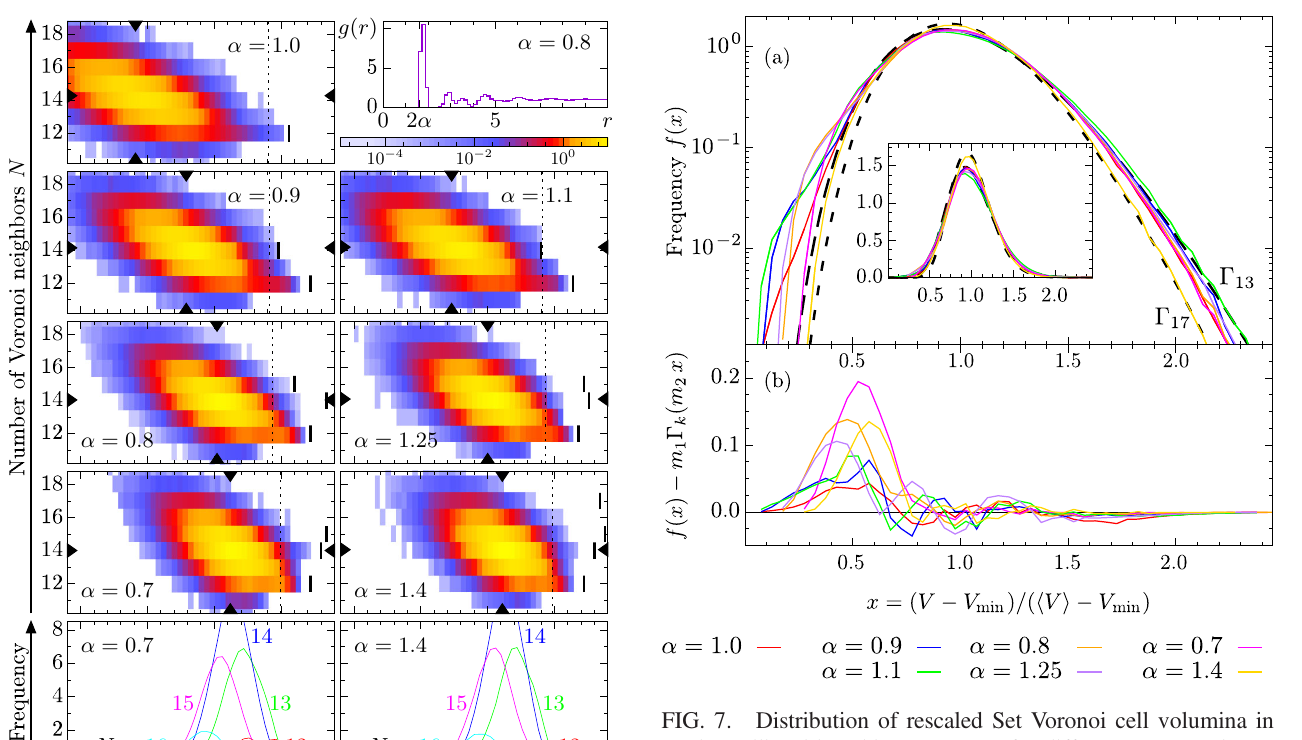
FIG. 7. Distribution of rescaled Set Voronoi cell volumina in random ellipsoid packings. (a) Data for different aspect ratios α , compared with two k -Gamma distributions with k ¼ 13 and k ¼ 17 . The inset shows the same data on a linear scale. (b) Residual after subtracting a best-fit k -Gamma distribution (see text). FIG. 6. Distribution of Voronoi neighbor count and local [7], and the cry